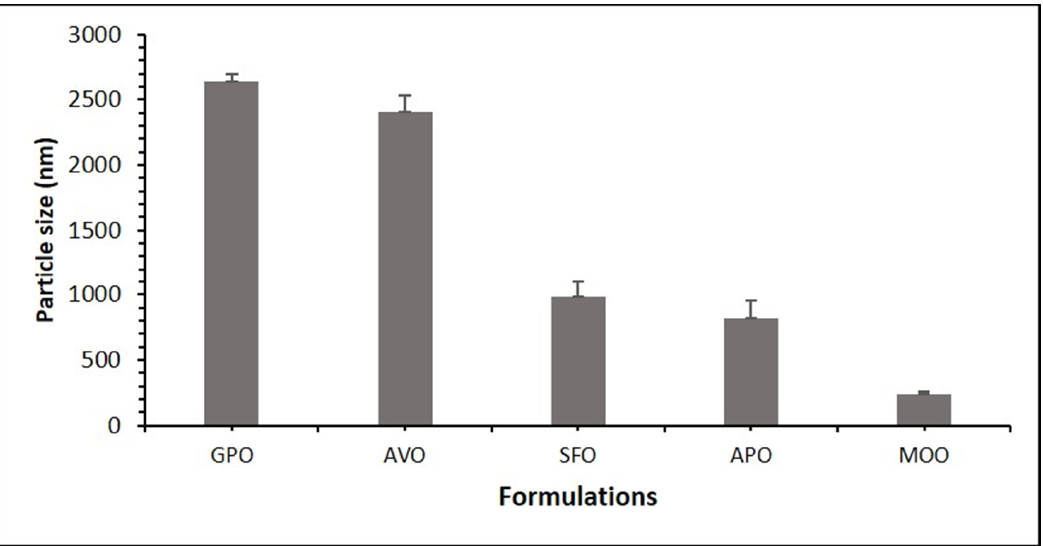
Figure 3. Effect of oils on the droplet size of the APG bioactive formulations. The excipients were mixed as % ( w / w ) at a fixed ratio. Bio-SNEDDSs were represented by GPO/I988/T80 (35/15/50)-F2, AVO/I988/T80 (35/15/50)-F1, SFO/I988/T80 (35/15/50)-F3, APO/I988/T80 (35/15/50)-F4, and MOO/I988/T80 (35/15/50)-F5, respectively.